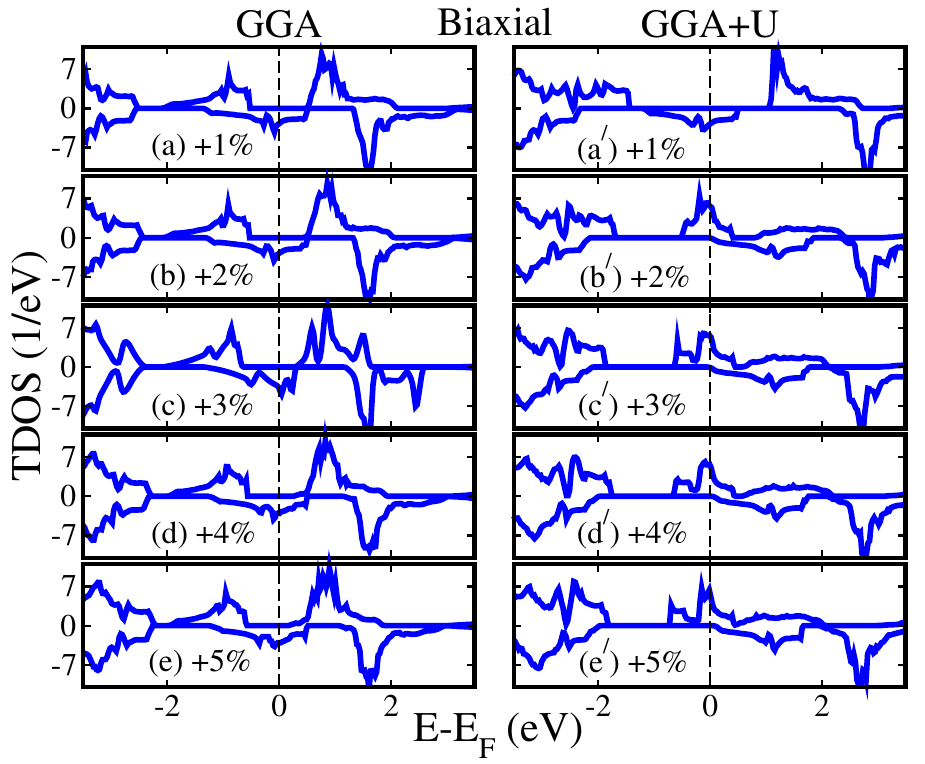
Figure 3. Calculated GGA/GGA+ U spin-polarized total density of states (TDOS) of Sr 2 CrReO 6 for ( a , a ′ ) + 1% , ( b , b ′ ) + 2% , ( c , c ′ ) + 3% , ( d , d ′ ) + 4% , and ( e , e ′ ) + 5% biaxial tensile strains along [110]-direction (in the ab